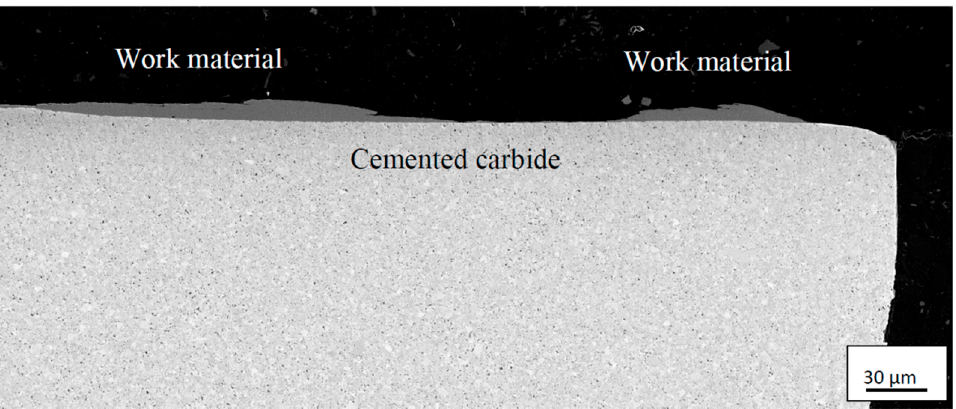
Figure 5 . Cross-section of cemented carbide insert showing the crater, partly filled with adhered work material, and flank wear regions. Cutting parameters: v c : 90 m/min, f n :0.2 mm/rev, t : 0.5 min.